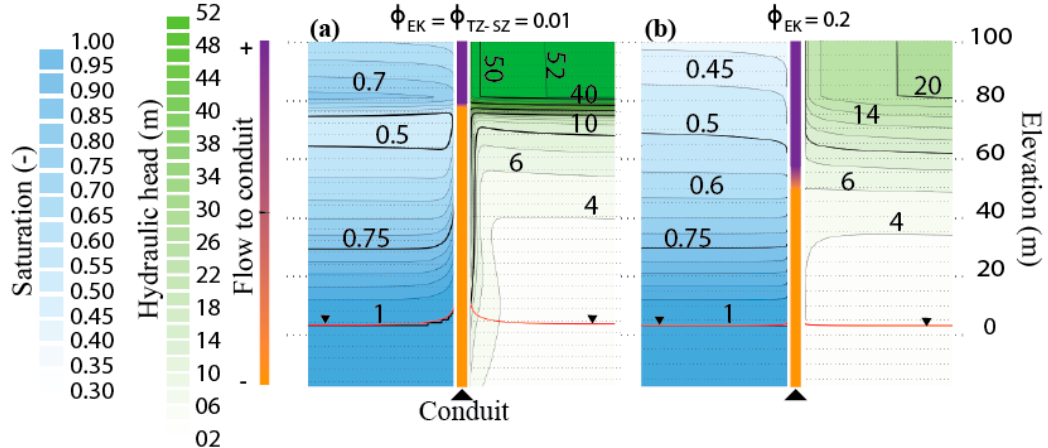
Figure 7. Profiles of the saturation (blue) and hydraulic head (green) around the conduit for various values of porosity of the epikarst. Each profile is taken at the time step for which the flux at the bottom output of the model is maximum. ( a ) The porosity is the same throughout the entire model and equal to 0.01. ( b ) The epikarst porosity is equal to 0.2.